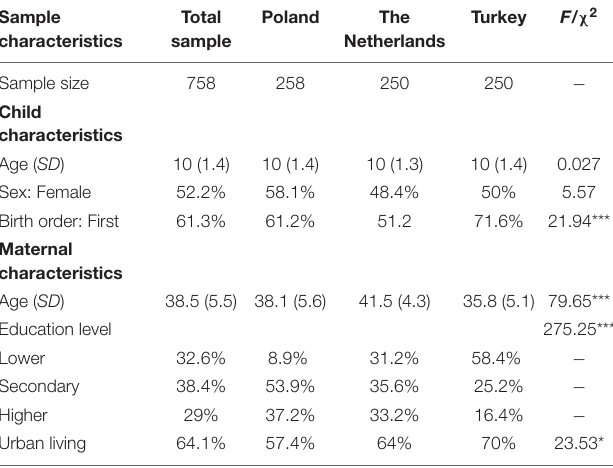
TABLE 1 | Demographic characteristics of the sample.